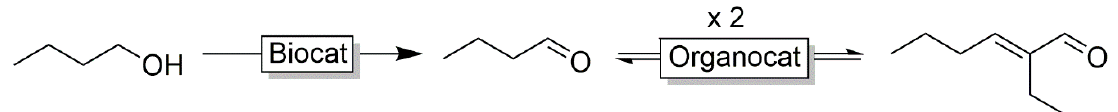
Table 3 . Selection of microbial through oxidations of primary alcohols.